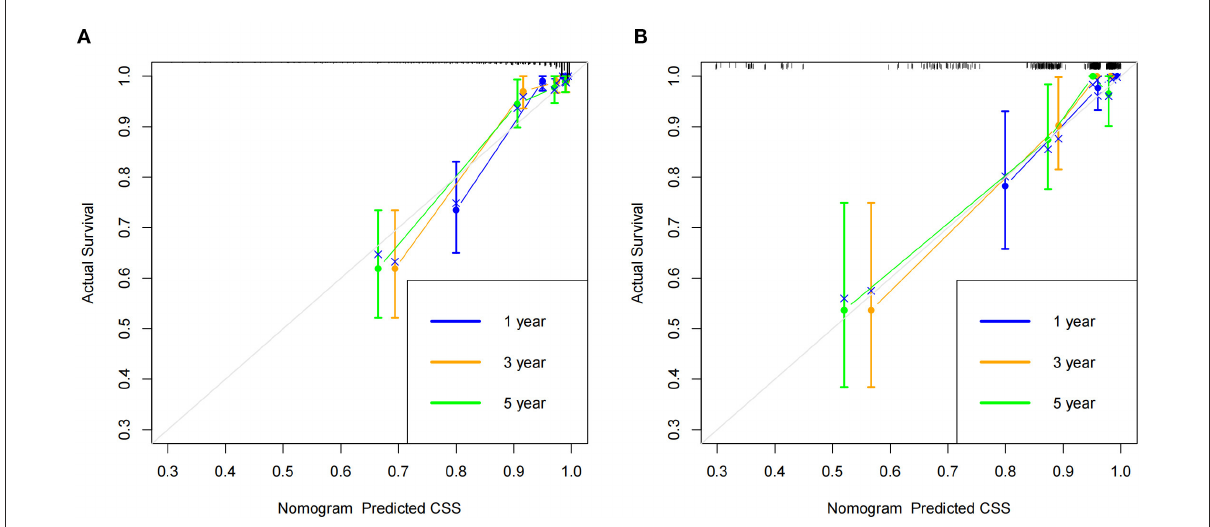
FIGURE3 Calibration curve of the nomogram. (A) Calibration curves of 1-, 3-, and 5-year CSS in the training set; (B) Calibration curves of 1-, 3-, and 5-year CSS in the validation set.